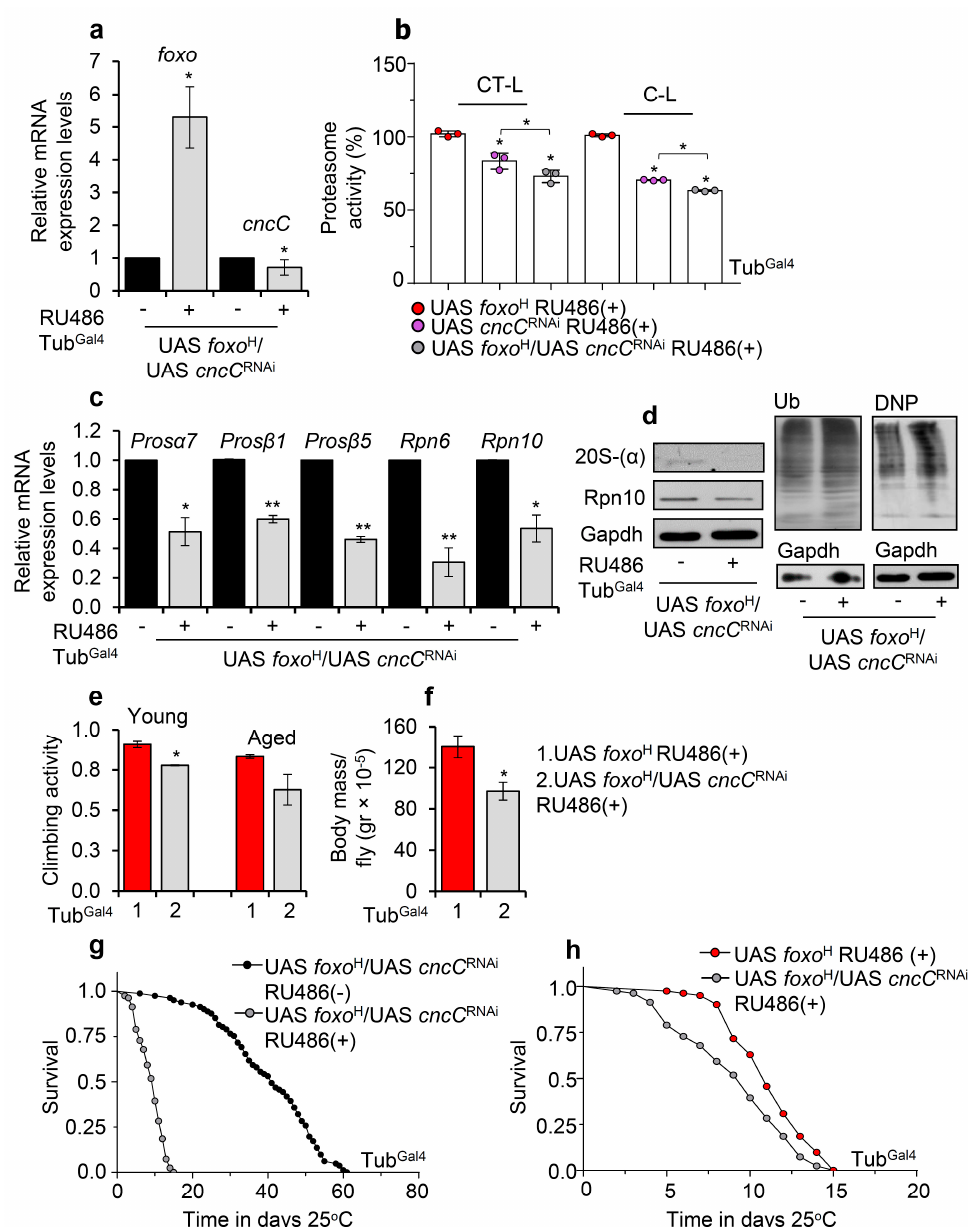
Figure 7. Proteasome activation after foxo OE is mediated by Nrf2/cncC. ( a ) Relative expression levels of foxo and Nrf2/cncC genes in the shown transgenic line after ubiquitous foxo H / cncC RNAi expression. ( b ) 26S (%) CT-L and C-L proteasome activity levels in flies’ somatic tissues after inducible ubiquitous foxo H / cncC RNAi expression vs. the respective control group; control values were set to 100%. ( c ) Relative expression levels (vs. controls) of proteasomal ( Pros α 7 , Pros β 1 , Pros β 5 , Rpn6 , Rpn10 ) genes in foxo H / cncC RNAi overexpressing transgenic flies. ( d ) Immunoblotting analyses showing 20S-( α ) and Rpn10 (proteasomal subunits) expression levels, as well as total ubiquitinated (Ub) and carbonylated (DNP) proteins in tissue lysates of foxo H / cncC RNAi overexpressing flies; Gapdh was used as a loading control. ( e ) Neuromuscular degeneration (climbing activity) during aging and ( f ) body mass per fly (gr × 10 − 5 ) of foxo H / cncC RNAi vs. foxo H overexpressing flies. ( g ) Longevity curves of foxo H / cncC RNAi overexpressing flies vs. respective controls or ( h ) as compared to foxo H overexpressing flies. Statistics of longevity assays are reported in Table S1. In ( a – d , f ), experiments were performed in young flies 7 days after induction of the transgenes. In ( a , c ), gene expression was plotted vs. controls set to 1. The RpL32 gene expression was used as input reference. Bars, ± SD; n ≥ 2, ≥ 10 flies were used per experimental repeat. Statistical significance was measured with unpaired t -test ( a , c , e , f ) or two-way ANOVA followed by Tukey’s multiple comparisons test ( b ), * p < 0.05, ** p <